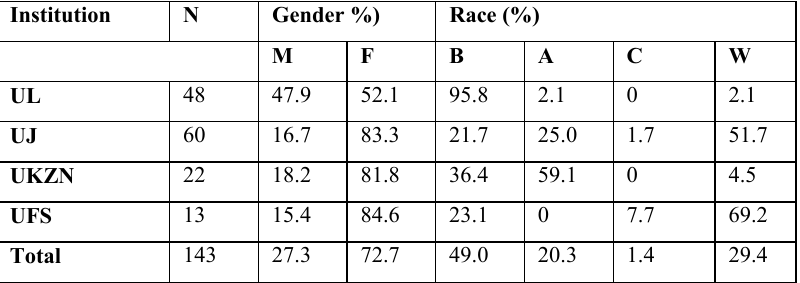
Table 3: Showing the institutions, number of participants, their gender and races: Blacks (B), Asians (A), Coloured (C), and Whites (W). Blacks dominated at UL, Whites at UJ and UFS and Asians at